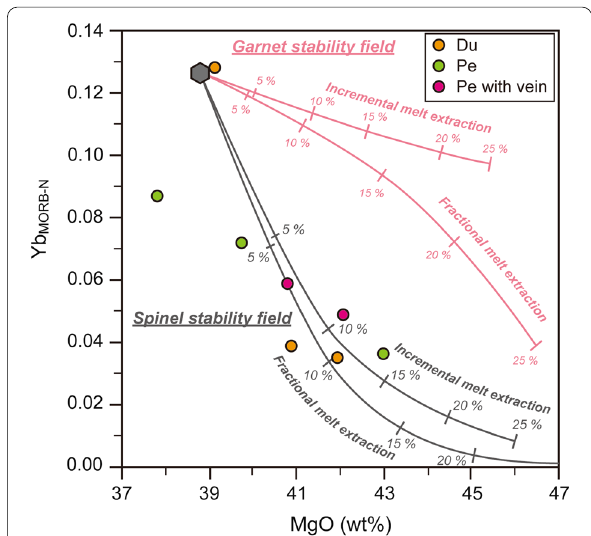
Fig. 12 Bulk compositional variation between MORB‑normalized (MORB‑N) Yb and MgO. Modeled melting trends during fractional and incremental batch melting of fertile mantle peridotite in the garnet stability field and spinel stability field are modified after Yoshikawa and Nakamura (2000). Abbreviations: Du dunite, and Pe = =